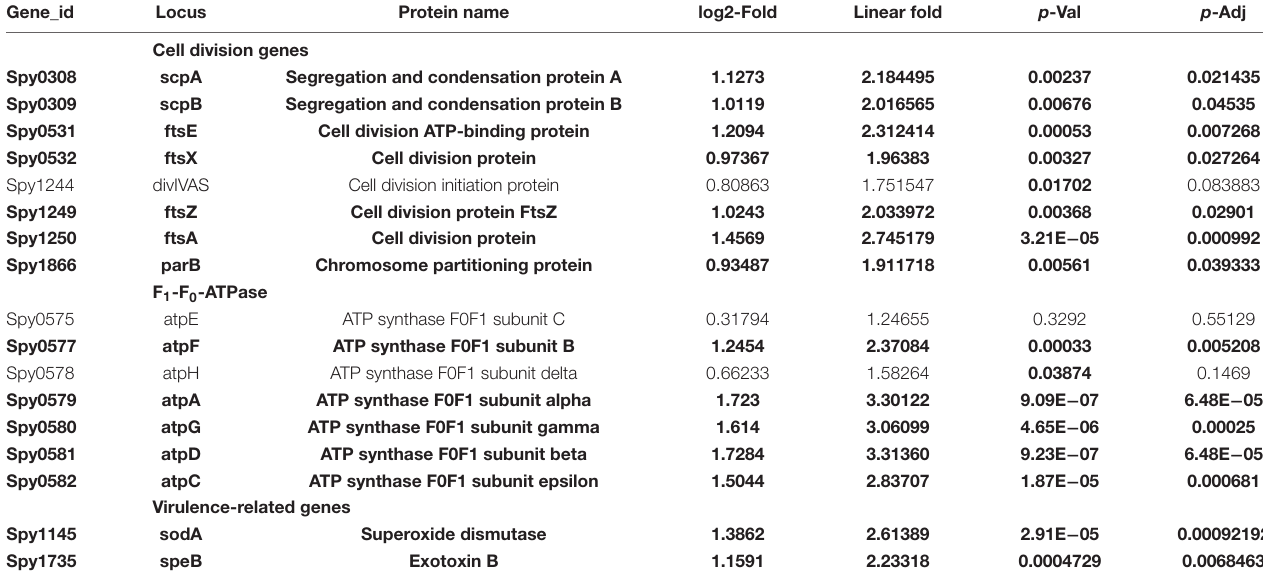
TABLE 1 | Transcript abundance of the major upregulated clustered genes in Streptococcus ( S.) pyogenes . in the absence of